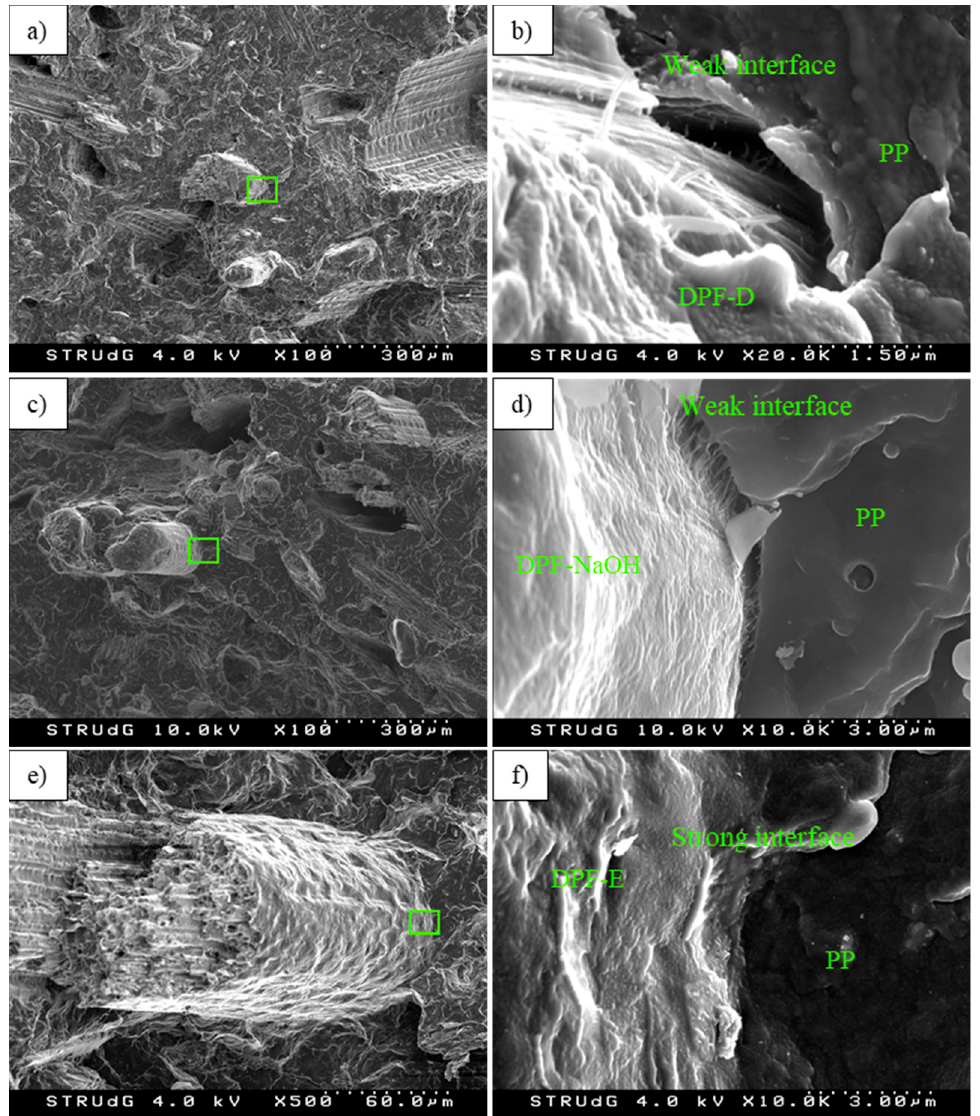
Figure 6. SEM images at the cross-sectional area of the composite specimens, at different magnifications. ( a , b ) PP + DPF-D; ( b , c ) PP + DPF-NaOH; ( e , f ) PP + DPF-E.